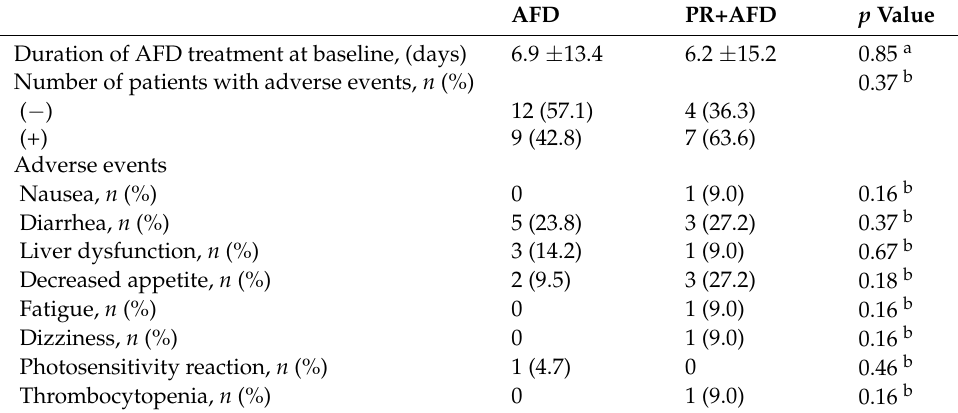
Table 4. Treatment adverse events in the AFD and PR+AFD